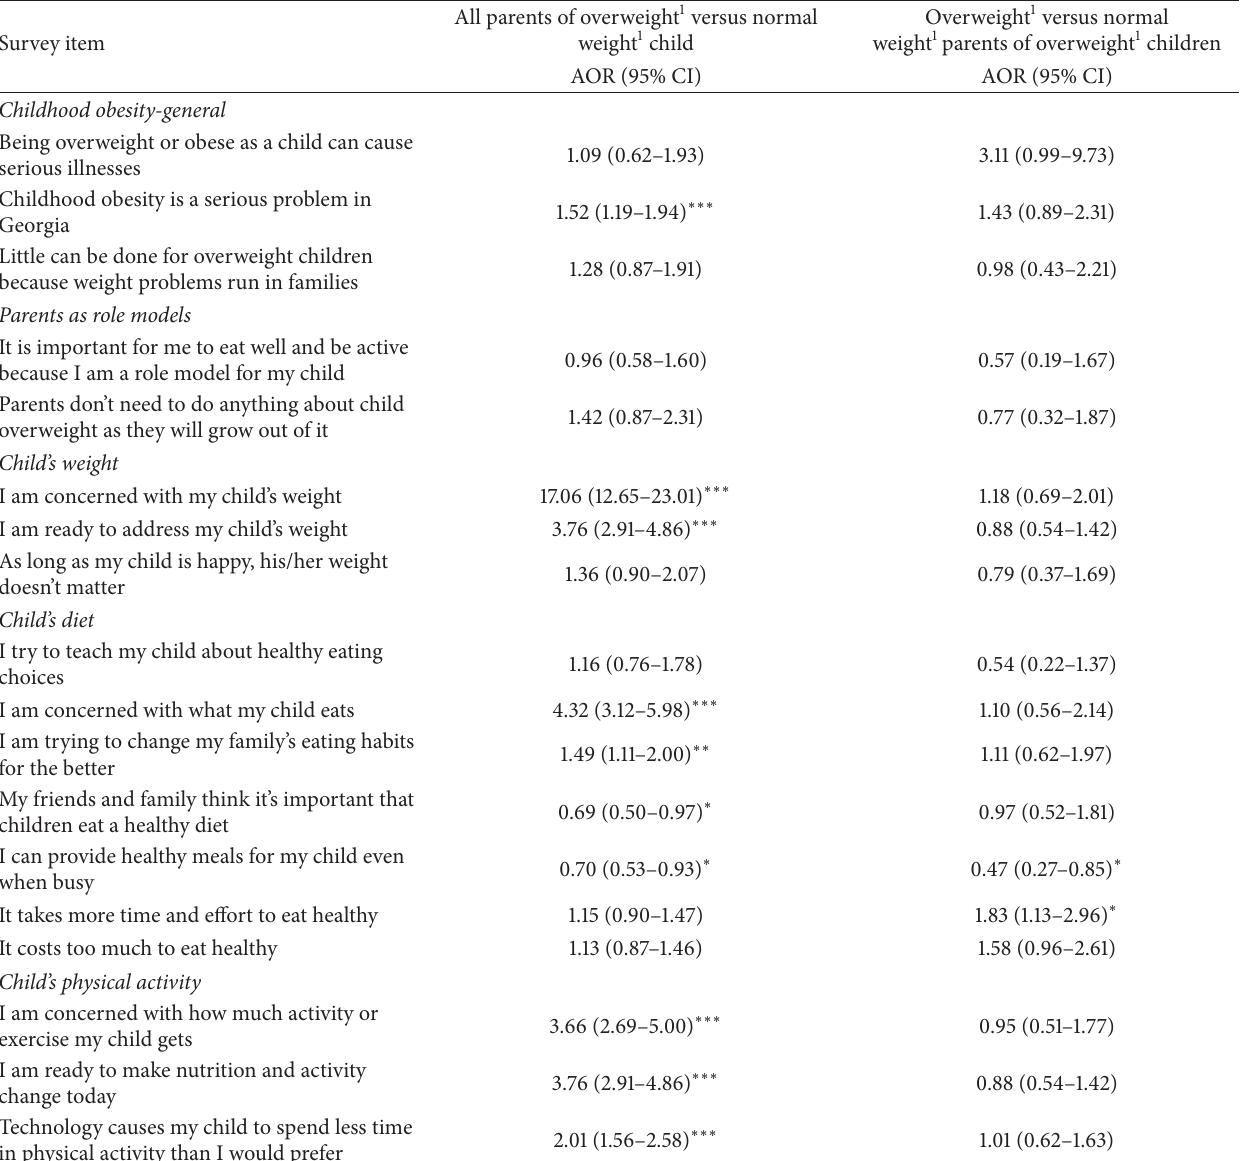
Table 3: Multivariable adjusted odds ratios (AORs) of parental agreement survey items related to childhood obesity, diet, and physical activity ( 𝑛 = 1811